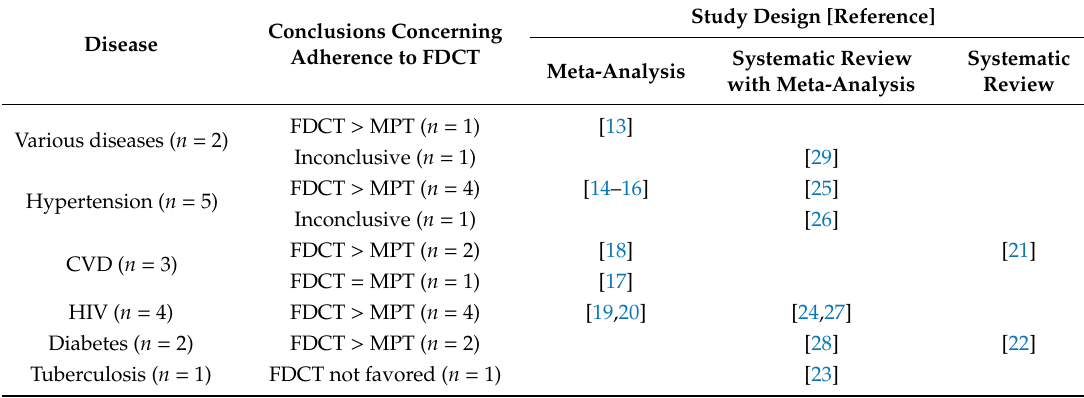
Figure 1. Preferred Reporting Items for Systematic Reviews and Meta-Analyses (PRISMA) flow chart of the article selection. Table 1. Summary of conclusions per disease in previously published systematic reviews and meta-analyses ( n =